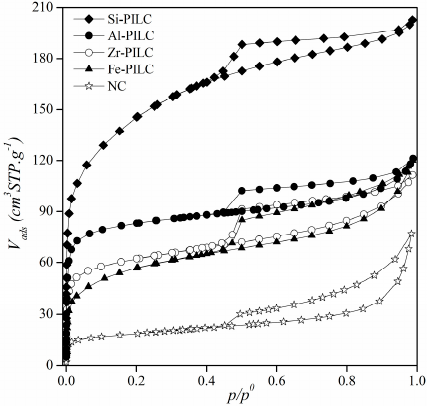
Figure 2. N 2 adsorption-desorption isotherms at 77 K for natural and pillared clay minerals.